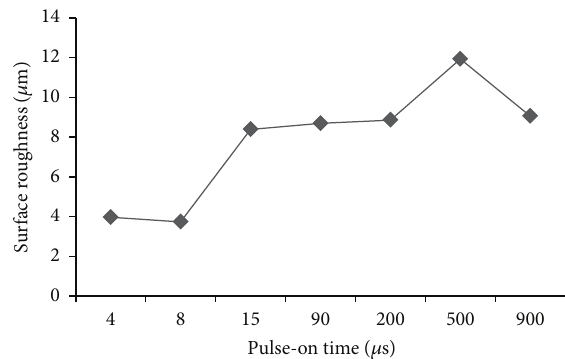
Figure 18: Influence of pulse-on time on SR at constant current 9 Amp, gap voltage 60, and pulse-off time 90 𝜇 s.